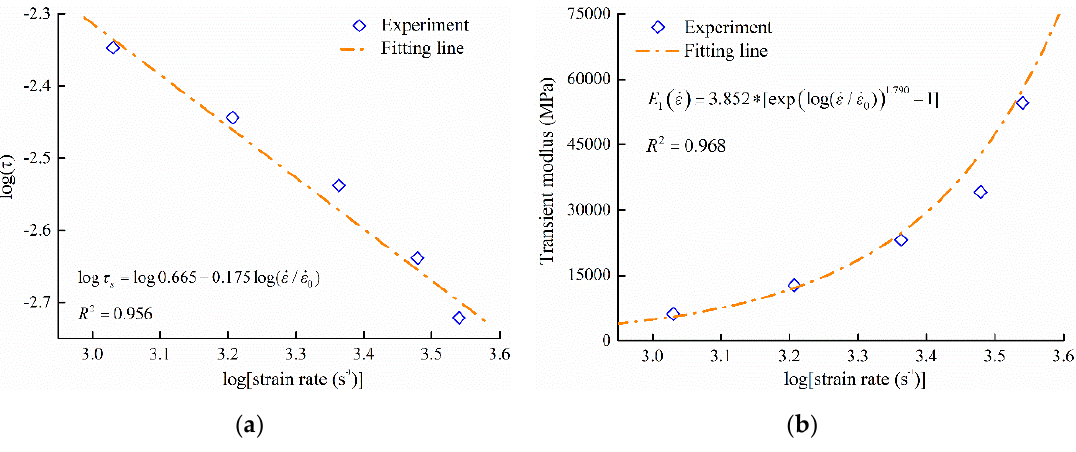
Figure 4. Fitting results of elastic parameters: ( a ) logarithmic forms of relaxation time; ( b ) transient modulus. Table 2. Parameters for constitutive model of PA66.